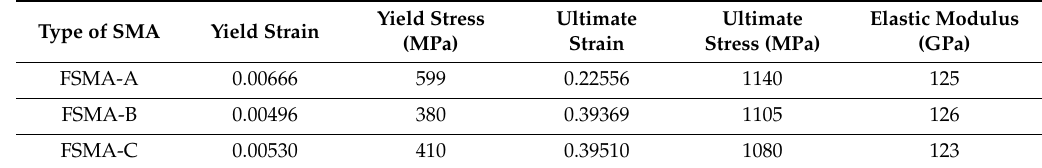
Figure 5. Comparison of stress ‐ strain curves by direct tensile test. Table 4. Summary of direct tensile test result.